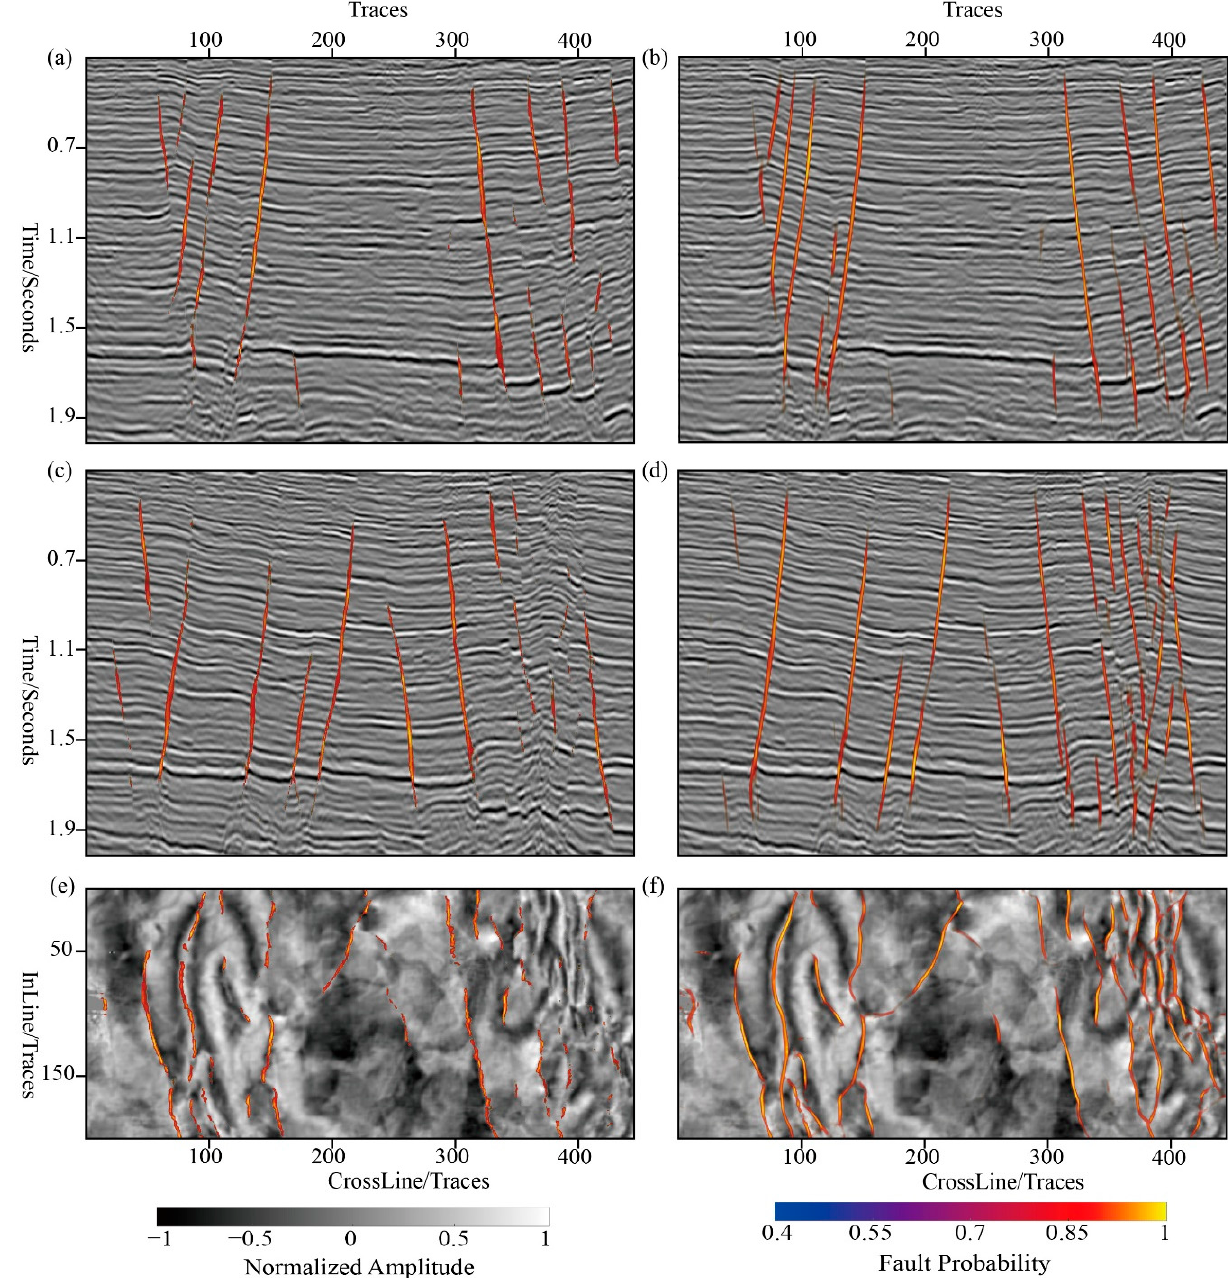
Figure 8. Faults detection results on the first 3D seismic data by using the pre-trained U-Net model (left column) and the U-Net model after transfer learning (right column), and all results are overlaid on corresponding seismic image. Vertical slices and horizontal slice are inline 50 (( a ) and ( b )), inline 150 (( c ) and ( d )) and time = 1500 ms (( e ) and ( f )), respectively.